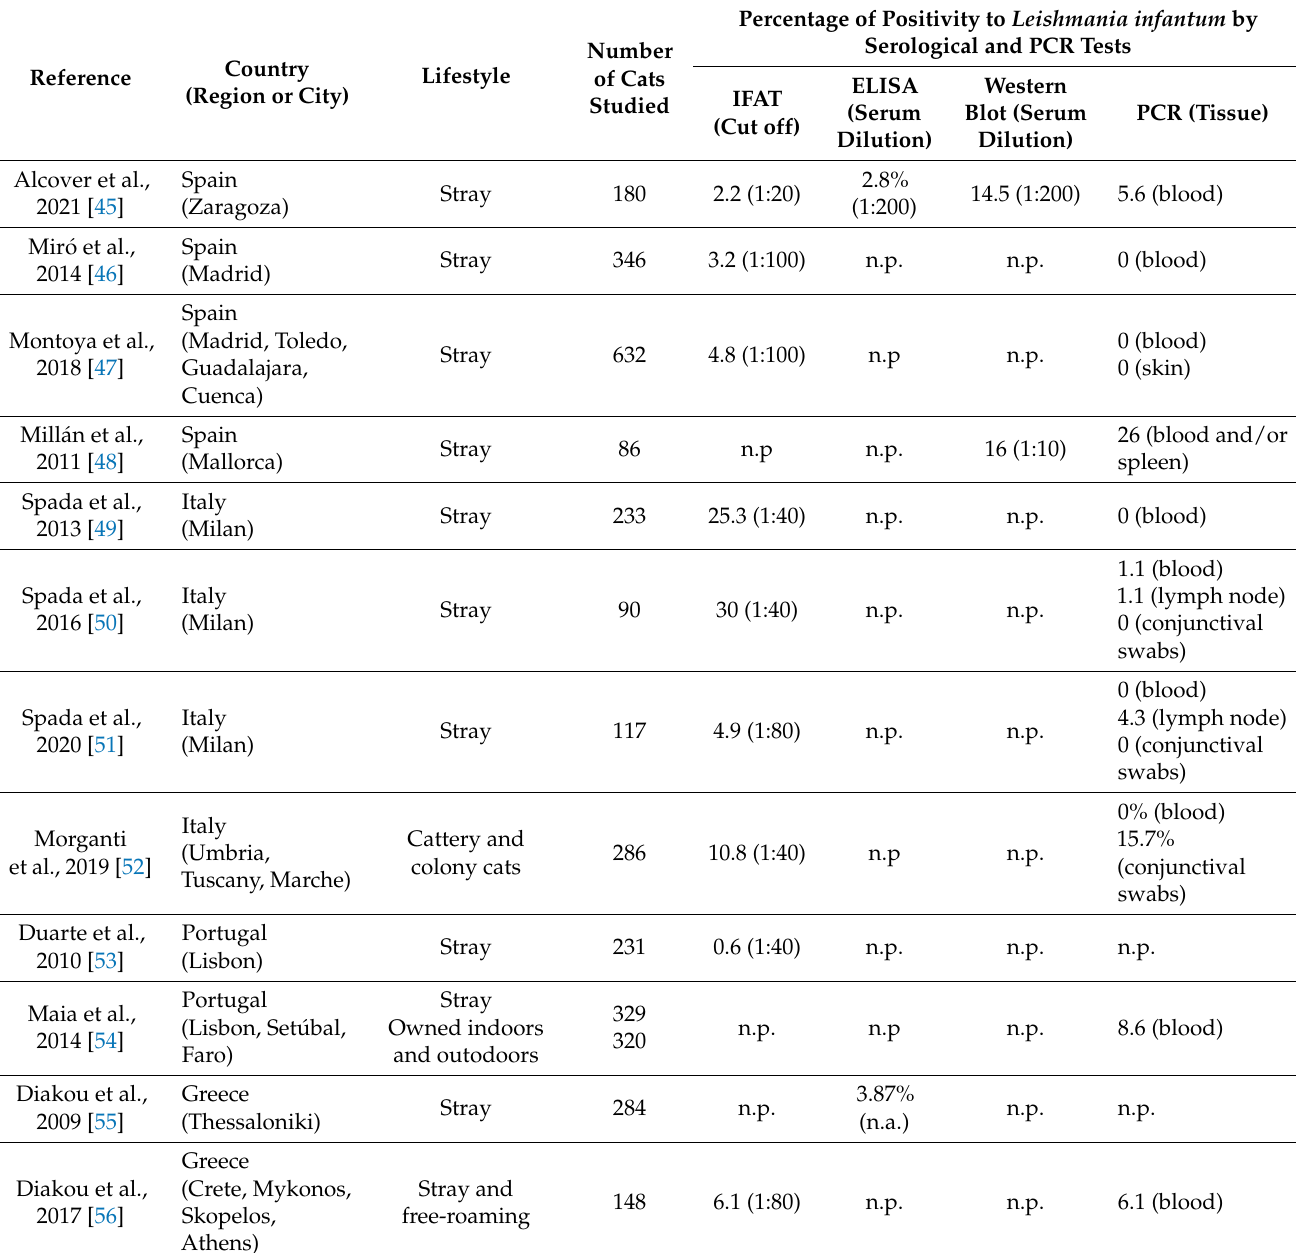
Table 4. Studies evaluating Leishmania infantum antibody and PCR prevalences in cats from European endemic